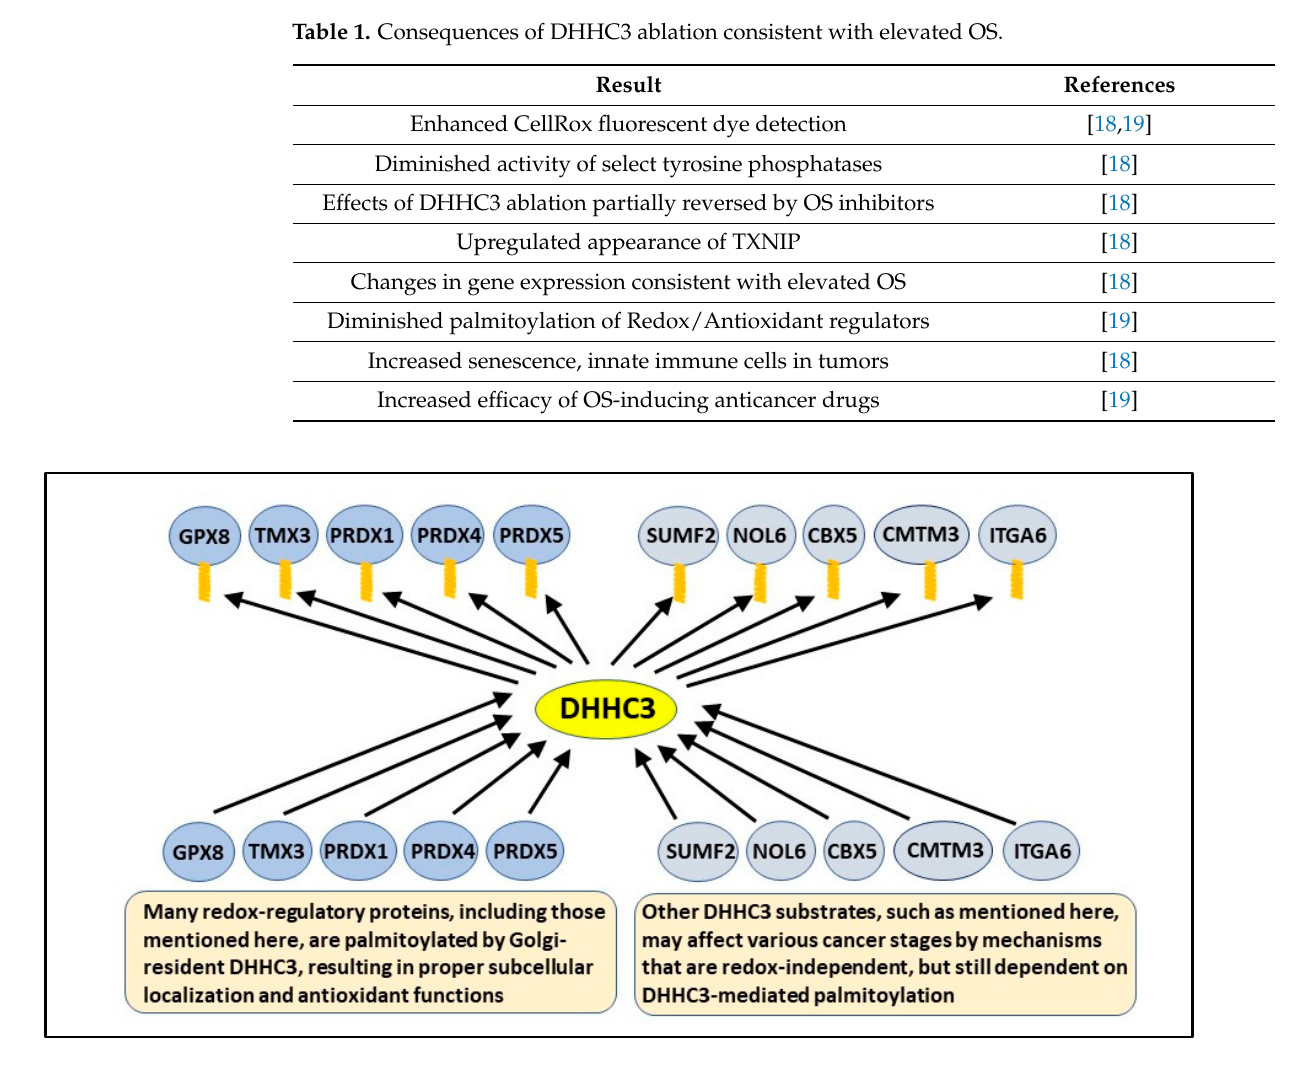
Figure 2. Key substrates most likely responsible for DHHC3 functions. During passage through the Golgi, several newly synthesized proteins are palmitoylated by DHHC3. For several antioxidant proteins (e.g., GPX8, TMX3, PRDX1, PRDX4, and PRDS5), palmitoylation facilitates their proper localization and function, thus controlling oxidative stress. Similarly, DHHC3-mediated pal- mitoylation enables the functions of additional proteins (e.g., SUMF2, NOL6, CBX5, CMTM3, and ITGA6) that may support various stages of tumorigenesis independent of redox regulation. Table 1. Consequences of DHHC3 ablation consistent with elevated OS .